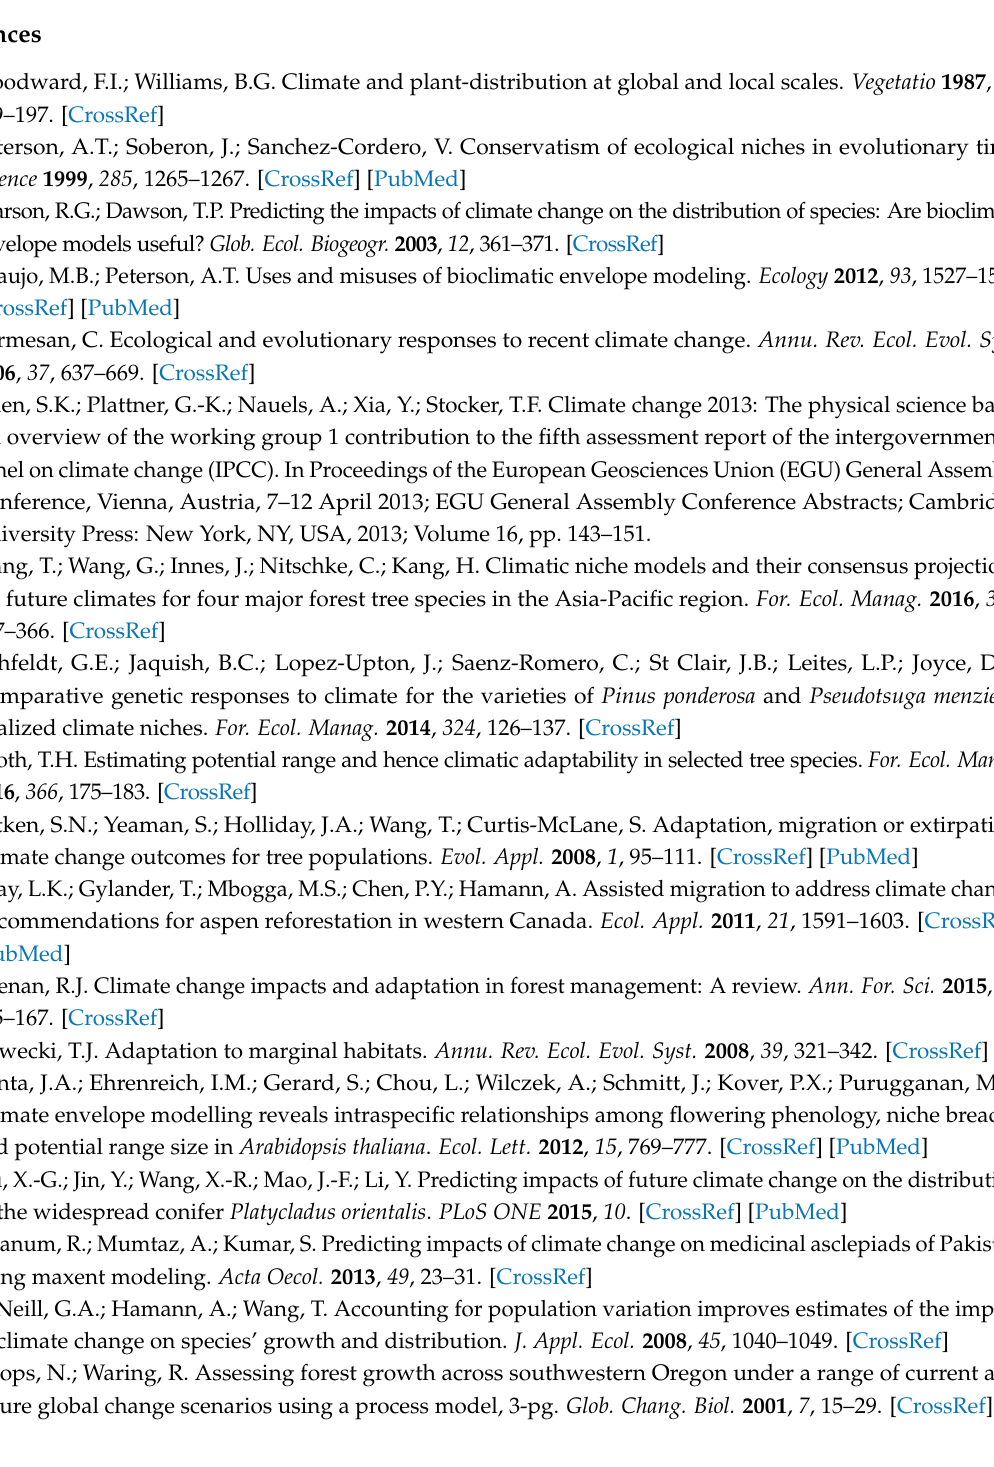
between group pairs. Table S4: The average altitude changes of five seed zones under the different future climate scenarios/years. Table S5: Dynamics of spatial changes of predicted habitats for the five seed zones under future climate